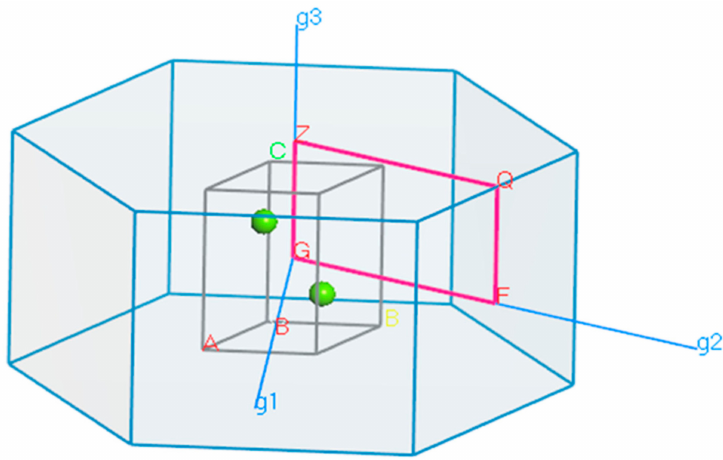
Figure 2. Brillouin zone of Mg structure for band structure calculations.